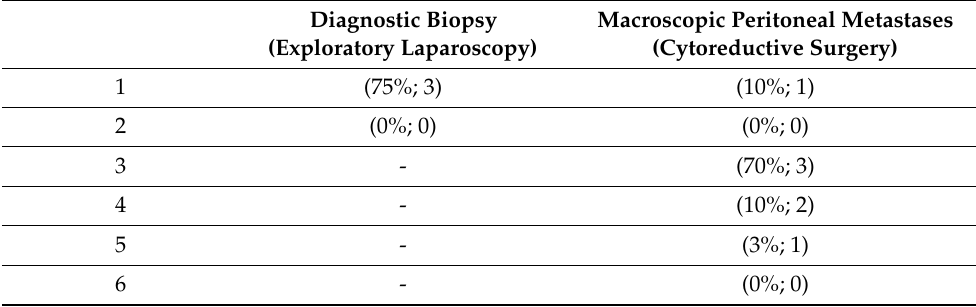
Table 3. FR α expression in patients without microscopic peritoneal metastases (percentage of FR α positive tumor cells; staining